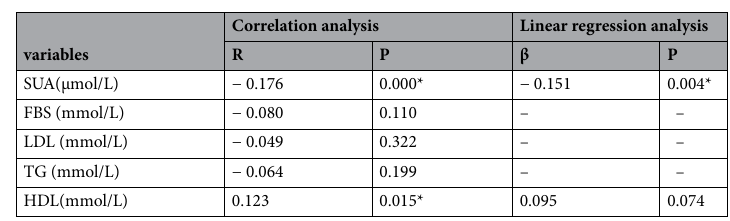
Table 2. Correlation and regression analysis of Bifidobacterium and metabolic indicators. *P < 0.05 Pearson correlation analysis showed Bifidobacterium was negatively correlated with SUA (R = − 0.176 P < 0.01). Bifidobacterium was positively correlated with HDL (R = 0.123, P < 0.05). Adjusting the age factor, multiple linear regression showed that SUA was an independent impact factor for Bifidobacterium (β = − 0.151, P = 0.004).